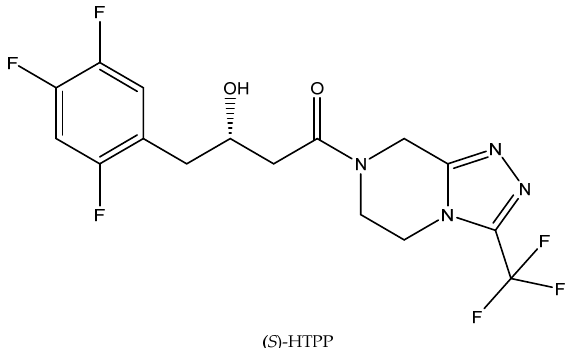
Figure 5. The structure of ( S )-HTPP. Reprinted from [45] with permission; copyright Springer Sci- ence and Business Media 2016). and Business Media